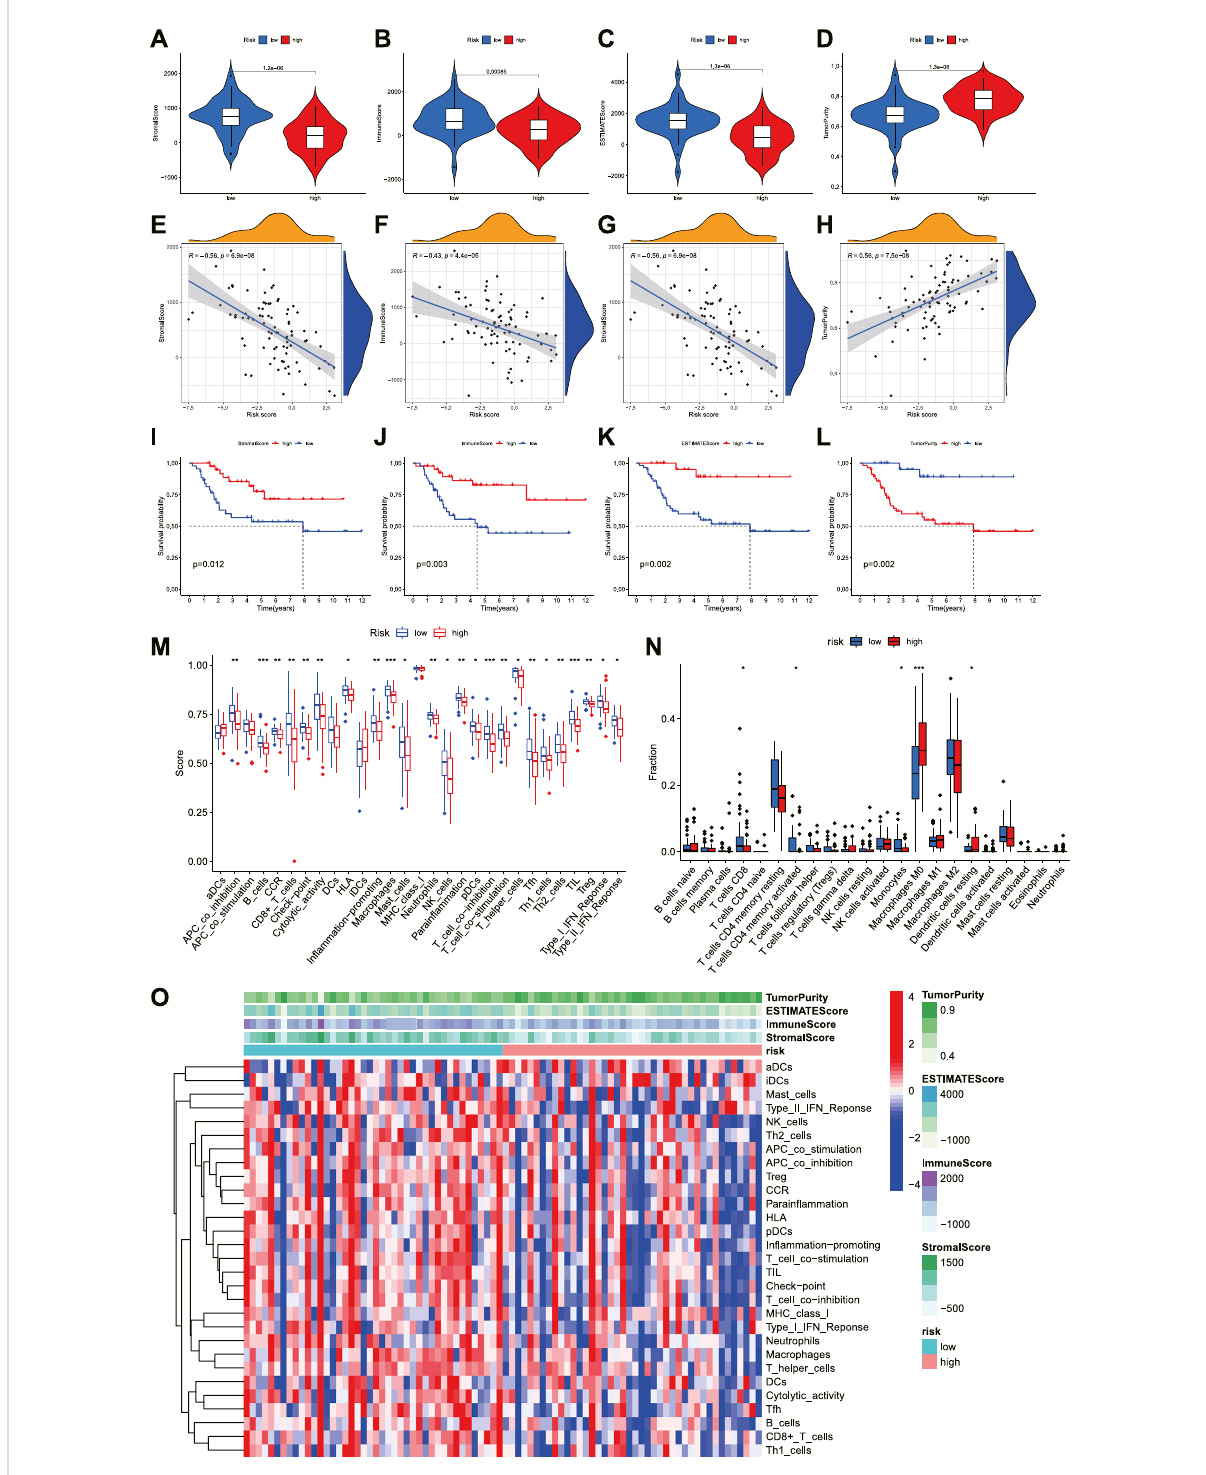
FIGURE 8 The investigation of immune status in OS. (A – D) . Comparisons between the two risk groups regarding stomal score, immune score, ESTIMATE score,andtumorpurity. (E – H) .Thecorrelationbetweenriskscore andstomalscore,immunescore,ESTIMATE score,andtumorpurity. (I – L) . (K – M) survival outcome is based on different stomal scores, immune scores, ESTIMATE scores, and tumor purity. (M) . The boxplot of tumor-in fi ltrating immune cell types in low- and high-risk groups. (N) . Boxplots of immune cells and immune-associated functions in low- and high-risk groups. (O) . Heatmap for immune status based ESTIMATE and ssGSEA among two risk